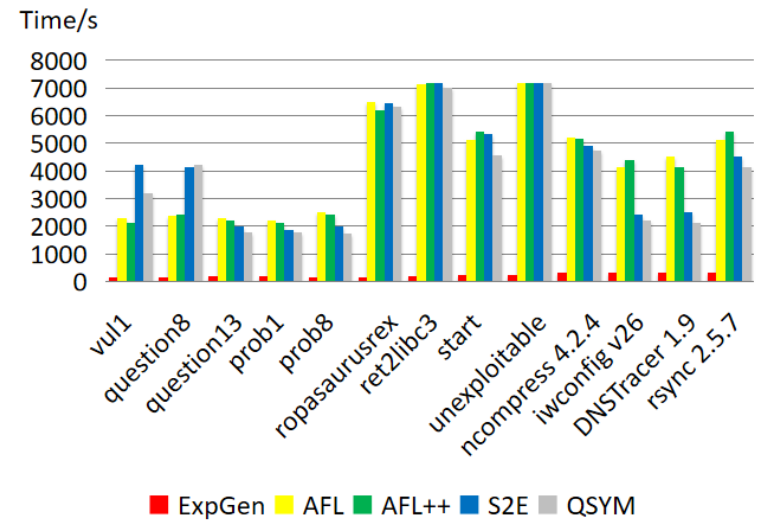
Figure 8. Time Cost in Partial Exploit Generation of each